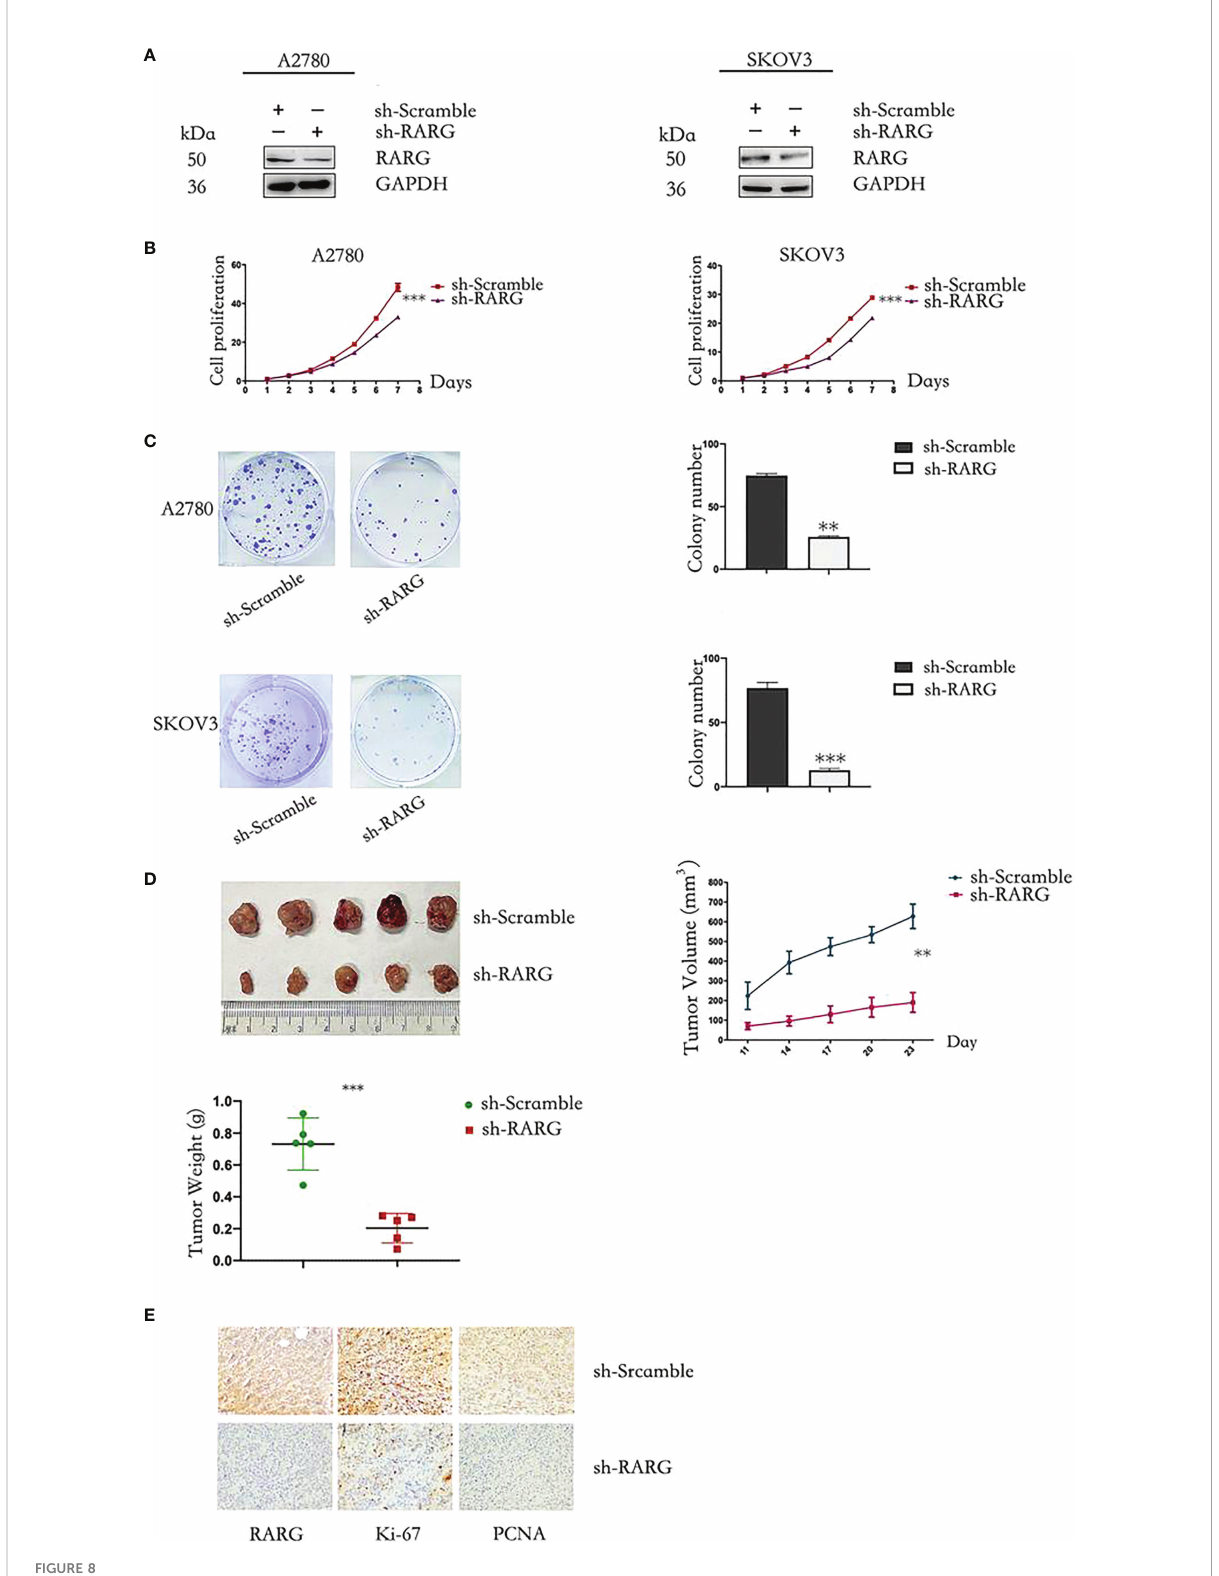
FIGURE 8 Knocking out RARG inhibited proliferation of OC cells. (A) Western blotting analysis of RARG expression in A2780 cells or SKOV3 cells transfected with RARG shRNA or scramble shRNA. (B) Cell proliferation was detected by the CCK-8 assay. (C) Cell Colony assay. (D) The xenograft tumors, tumor growth curve and weight of xenograft tumors. (E) Immunohistochemistry analysis of RARG, Ki-67 and PCNA protein levels in sh-Scramble group and sh-RARG group. Scale bar = 1 cm. **P < 0.01; ***P <